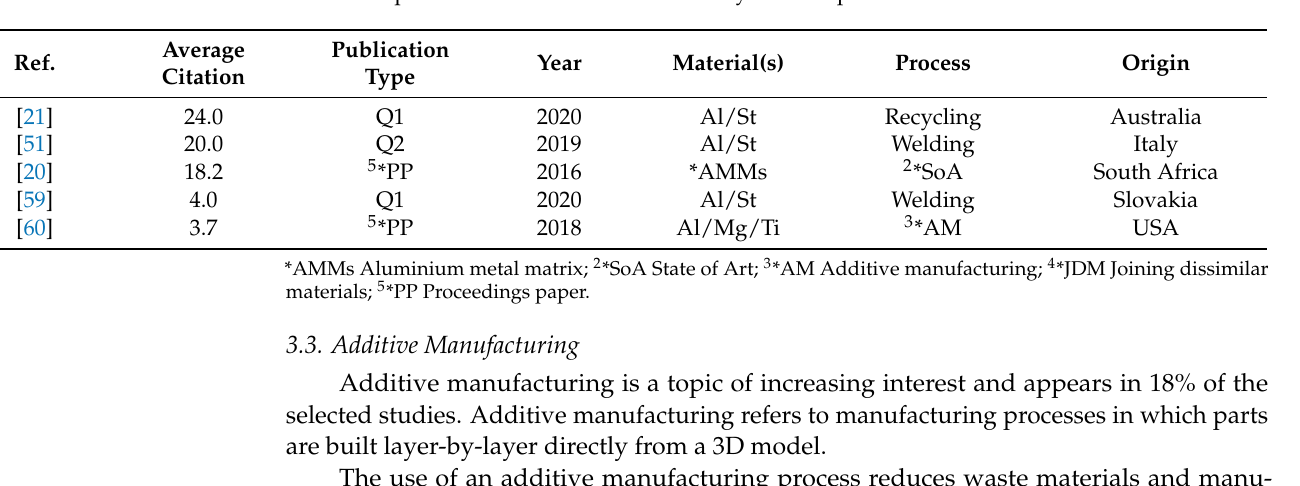
Table 5. Top 5 articles on multi-materials or hybrid